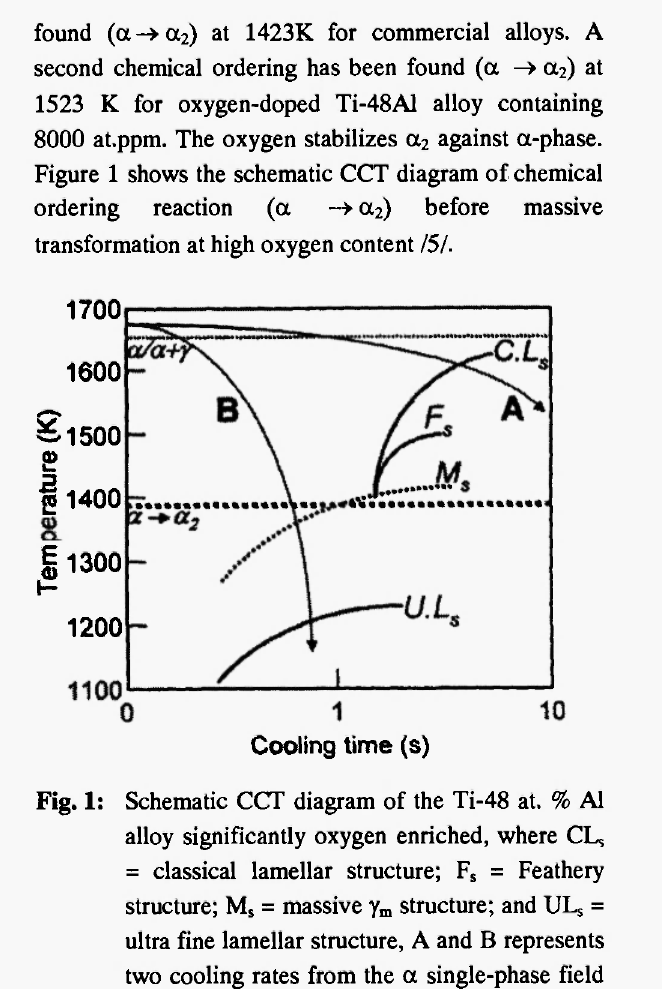
Fig. 1: Schematic CCT diagram of the Ti-48 at. % Al alloy significantly oxygen enriched, where CLj = classical lamellar structure; F = Feathery s structure; M = massive y structure; and ULs = s m ultra fine lamellar structure, A and Β represents two cooling rates from the α single-phase field